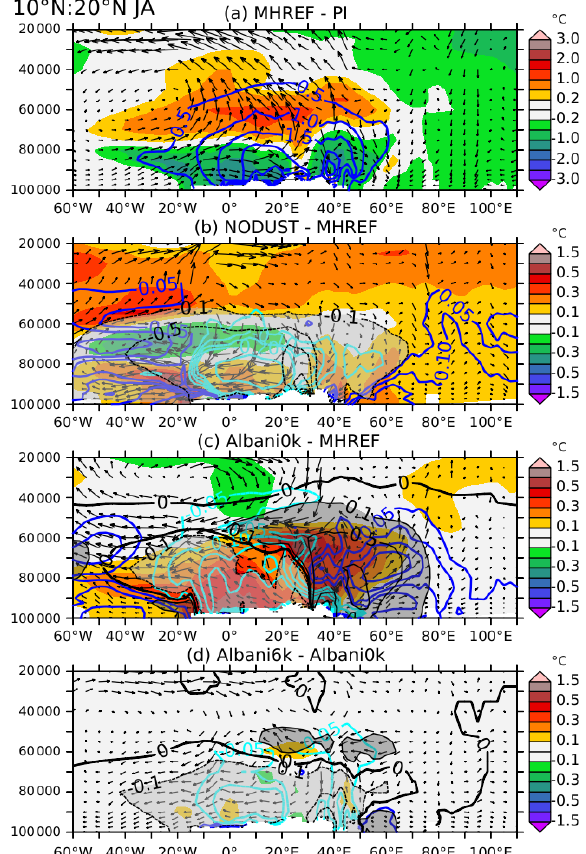
Figure 13. As in Fig. 12, but for the atmospheric meridional circu- lation averaged from 10 to 20 ◦ N. These changes reflect the changes at the northern edge of the boreal summer monsoon rain belt in Africa for (a) MHREF-PI, (b) NODUST–MHREF, (c) Albani0k– MHREF and (d)